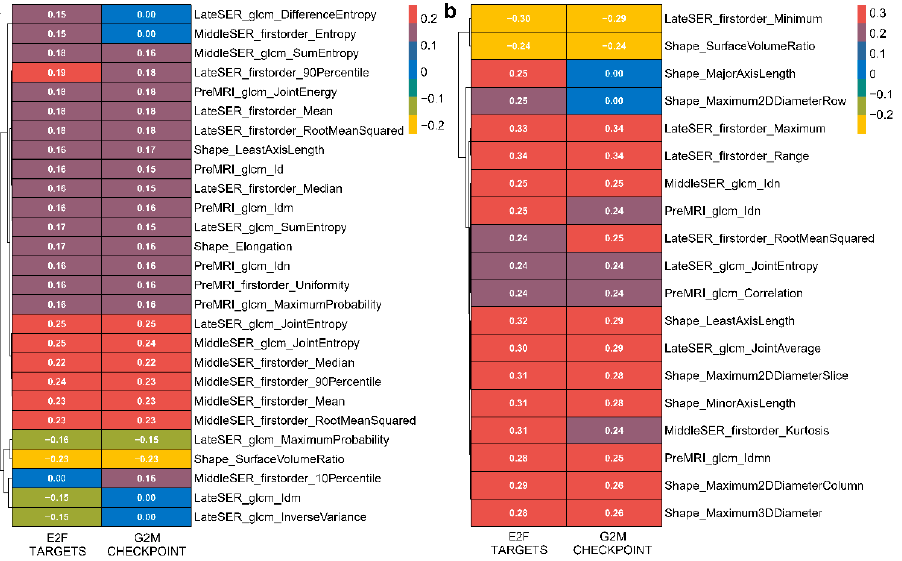
Figure 4. Quantitative associations of GSVA enrichment scores of two cell cycle-related hallmark pathways with imaging features. The significant Pearson correlation coefficients of the enrichment scores of both “E2F TARGETS” and “G2M CHECKPOINT” pathways with the imaging features for the discovery and validation cohorts are detailed in ( a ) and ( b ), respectively. Non-zero values in the cells represent significant correlation coefficients, and zero represents non-significant correlation coefficients.